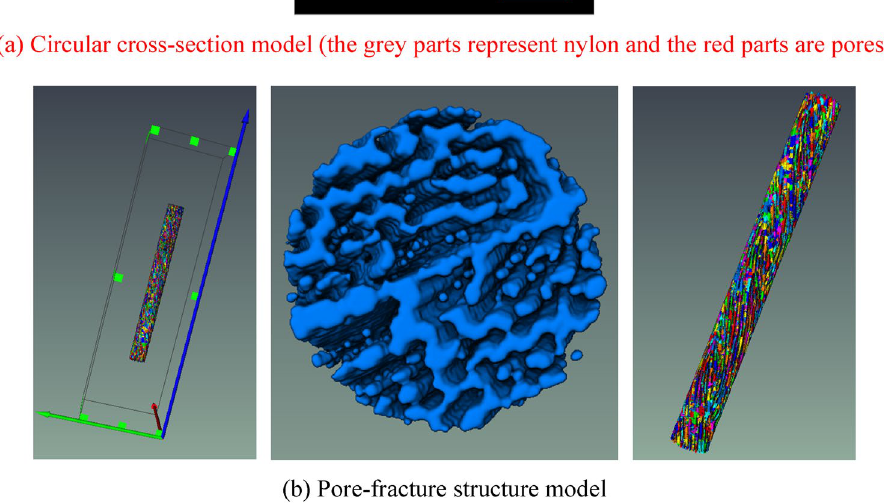
Figure 9. Three-dimensional distribution of the